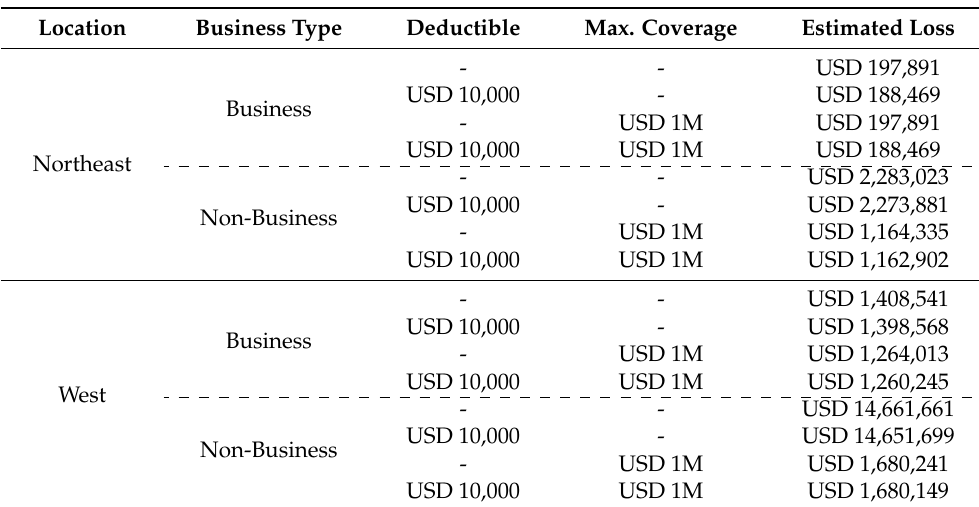
Table 8. Quarterly aggregate loss in dollar